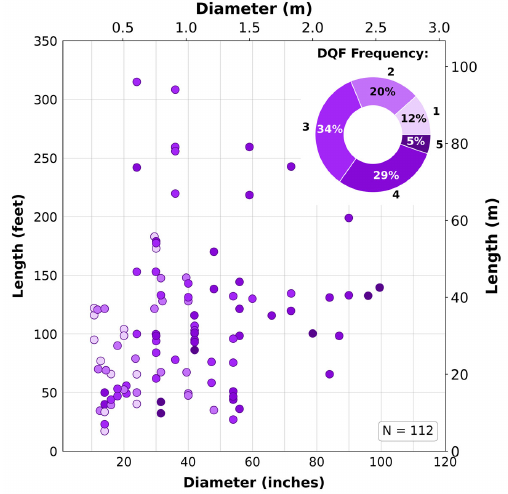
Figure 1. Length, diameter, and DQF information of the employed piles.